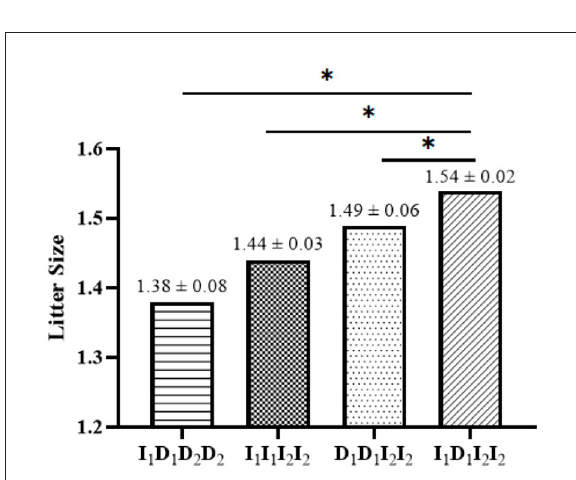
FIGURE3 Least squares mean and standard error for litter size of different combination genotypes of the two InDels within the SNX29 gene in SBWC goats. The 1 means P1-Del-17bp, 2 means P2-Del-20bp; The * means P < 0.05. and the 20 bp deletion ( P = 1.000E-6) within the SNX29